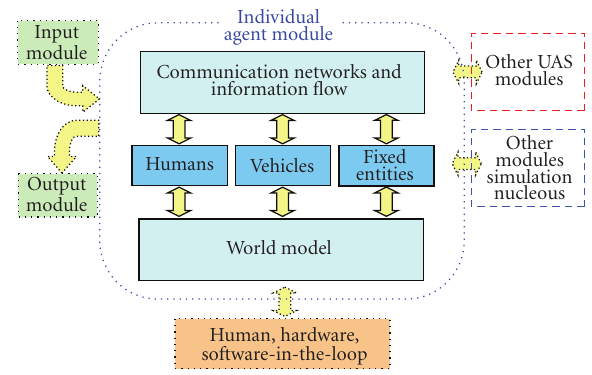
Figure 4: UAS-SE—individual agent